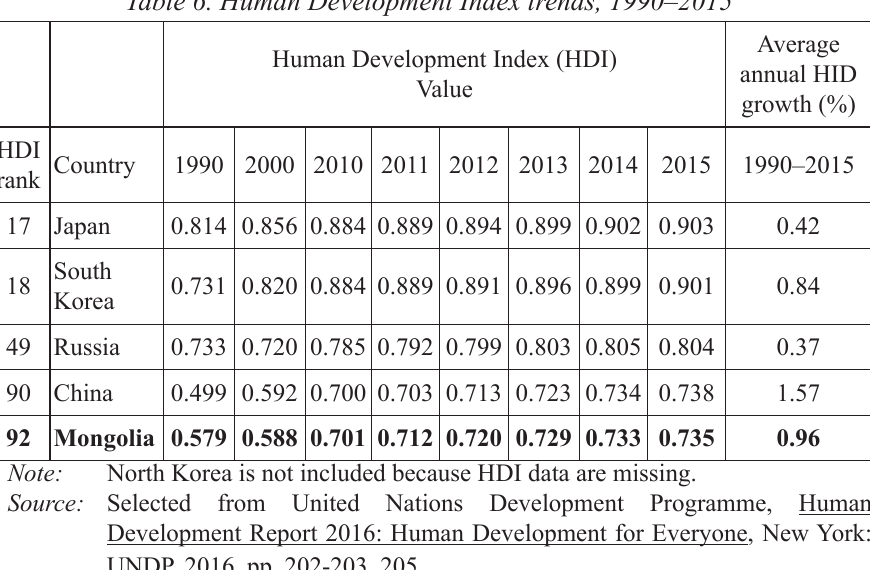
Table 6. Human Development Index trends, 1990–2015 Human Development Index